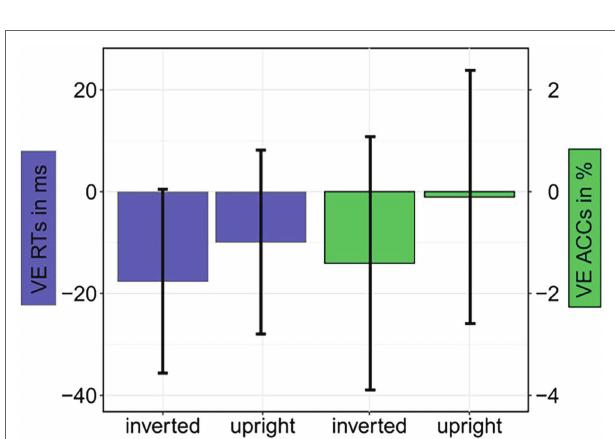
FIGURE 5 | Experiment 1: Mean validity effect (VE) in reaction times (RTs; invalid minus valid; blue bars) and accuracies (ACCs; valid minus invalid; green bars) depending on Cue Orientation (upright; inverted). Error bars represent 95% confidence